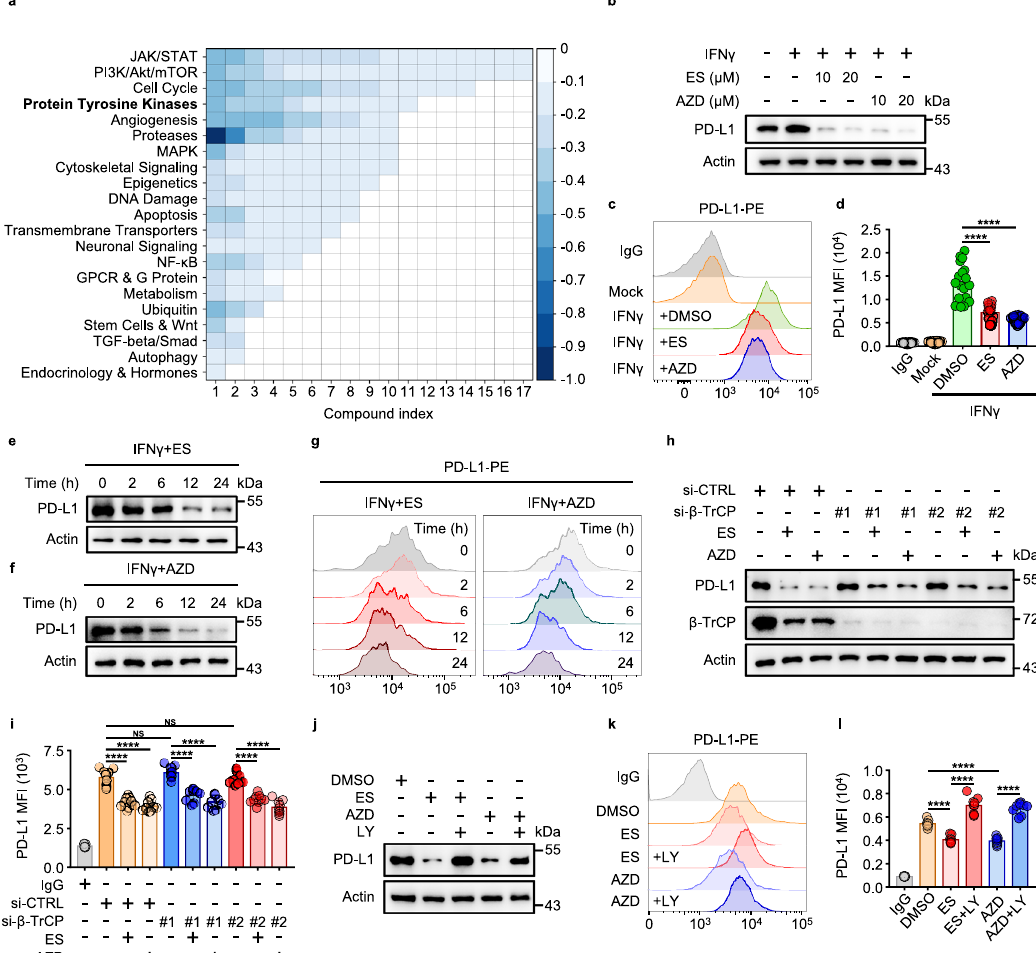
Fig. 1 EGFR inhibitors were screened to reduce membrane PD-L1 levels. a High-throughput screening of 2125 FDA-approved drugs or drug candidates. U937 cells were incubated with IFN γ (100ng/mL) for 48h, treated with the drugs at 10 μ M for 12h. Ruxolitinib (Rux) was used as a positive control. The hit compounds that induced the decrease of PD-L1 levels are shown in blue. The depth of blue represents decreased level of PD-L1. The heatmap represents the targeted pathways obtained from the high-throughput screening, based upon decreased membrane PD-L1 level detected by fl ow cytometry. b Immunoblotting of PD-L1 in U937 cells treated with ES-072 (ES) or AZD9291 (AZD) at indicated concentrations for 12h. ES and AZD are EGFR inhibitors. c , d Median fl uorescence intensity (MFI) ( c ) and relative quanti fi cation ( d ) of PD-L1 in U937 cells treated with 10 μ M ES-072 or 10 μ M AZD9291 for 12h. Data represent means±SEM, n = 18, 6 independent repeats, **** P <0.0001. e – g Immunoblotting ( e , f ) and fl ow cytometry ( g ) analysis of PD-L1 levels in U937 cells treated with 10 μ M ES-072 or 10 μ M AZD9291 for the indicated times. h , i Immunoblottings ( h ) of PD-L1 and β -TrCP, relative quanti fi cation ( i ) of PD-L1 MFI in H1975 cells transfected with non-targeting siRNA (si-CTRL) or β -TrCP siRNAs (si- β -TrCP) and treated with or without 10 μ M ES-072/AZD9291 for 12h. Data represent means±SEM, n = 9, 3 independent repeats, NS: no signi fi cant; **** P <0.0001. j – l Immunoblotting ( j ) and fl ow cytometry analysis ( k ) with relative quanti fi cation ( l ) of PD-L1 in H1975 cells treated with 10 μ M ES-072 or AZD9291, and/or 5 μ M LY2090314 (LY) for 12h. LY is a GSK3 inhibitor. Data represent means±SEM, n = 9, 3 independent repeats, **** P <0.0001. Source data are provided as a Source Data fi